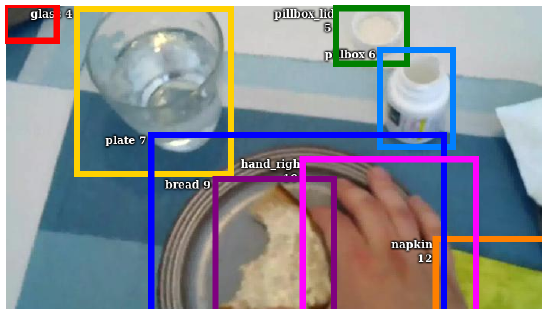
Figure 4. Example bounding boxes. It depicts a usual frame that was captured by our smart-glasses. We draw the bounding box for each object, even if it was only partly visible. The boxes were tagged concerning the visibility state of the